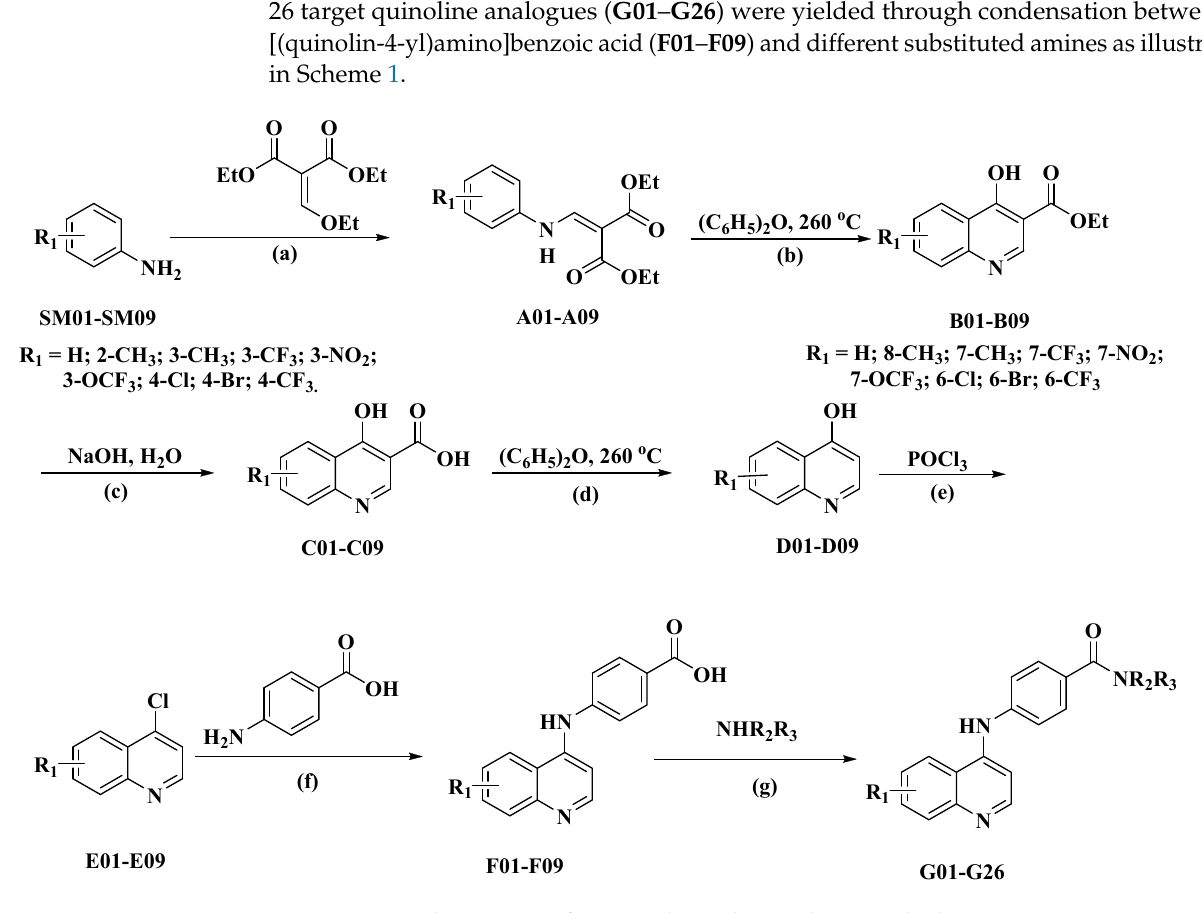
Table 1. The results of compounds G01 – G26 in cytotoxicity assay, cytopathic effect assay, plaque inhibition assay and PA–PB1 inhibitory activity